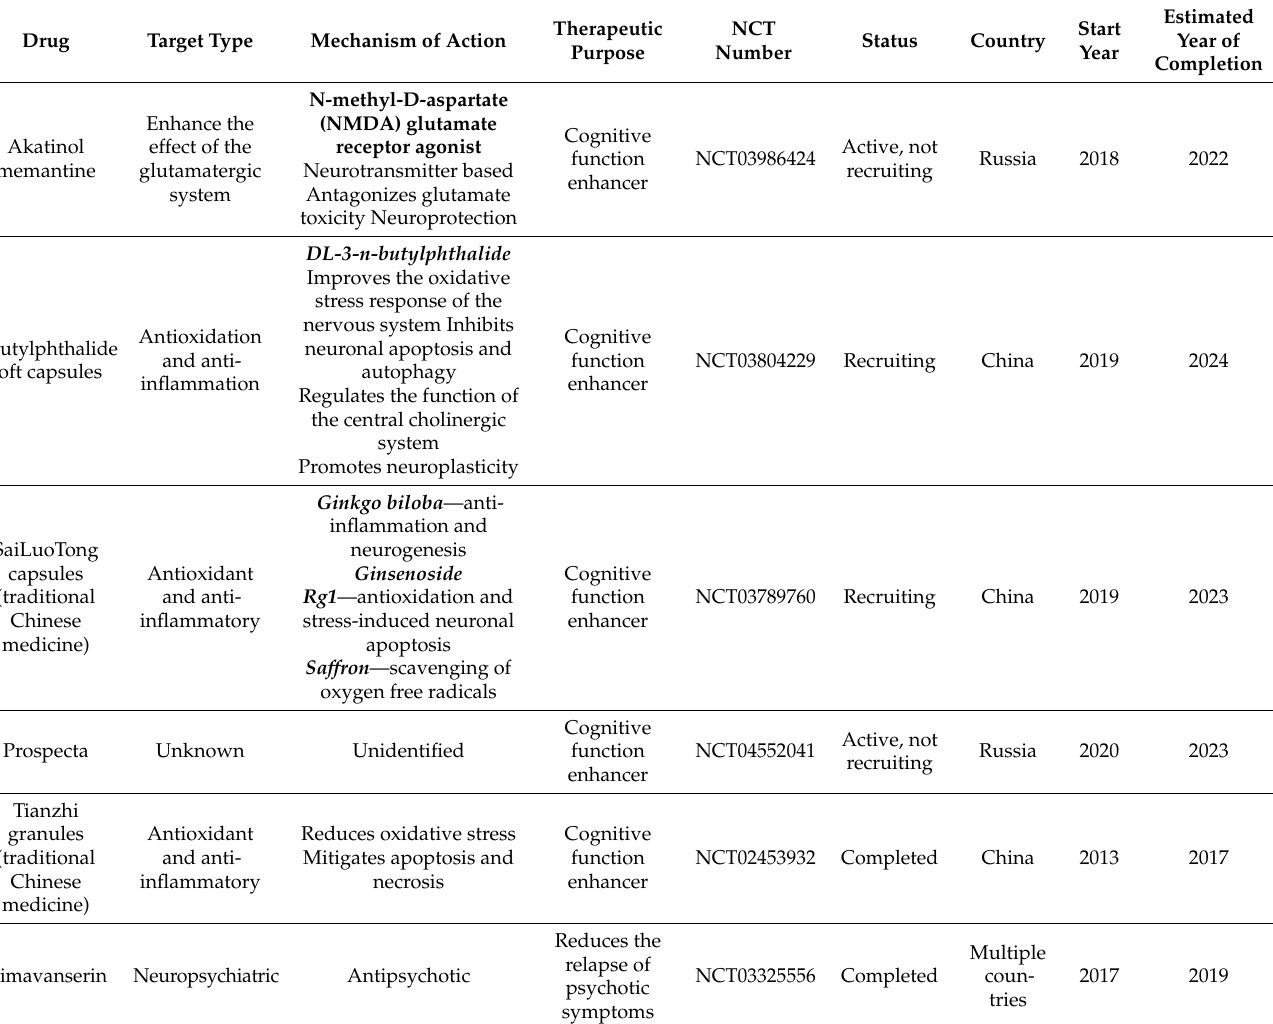
Table 1. Therapeutic agents for VCI and VaD treatment in phase III testing.